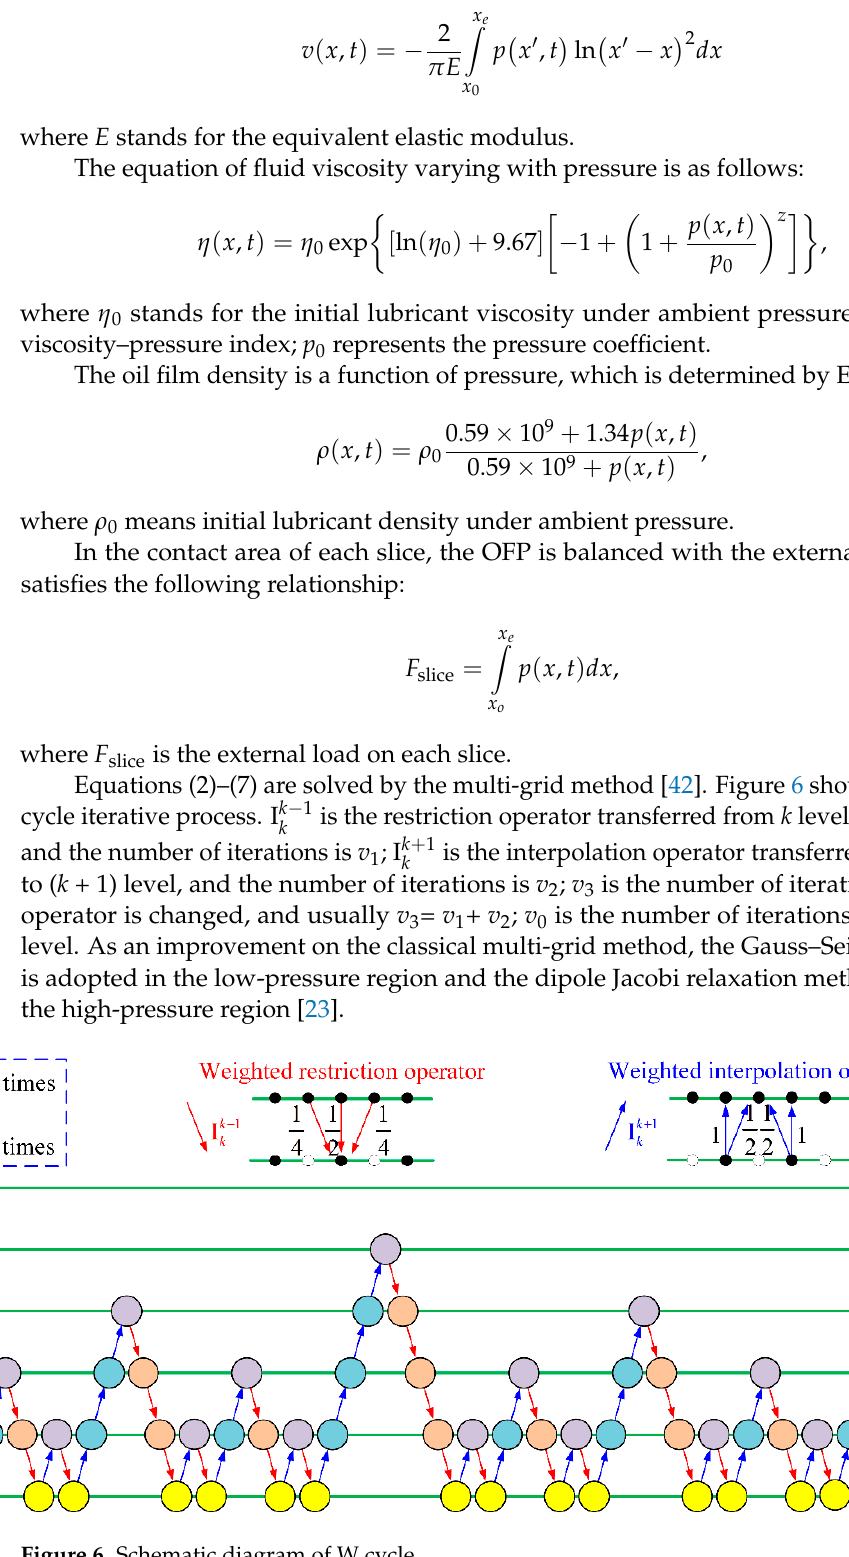
Figure 6. Schematic diagram of W cycle.